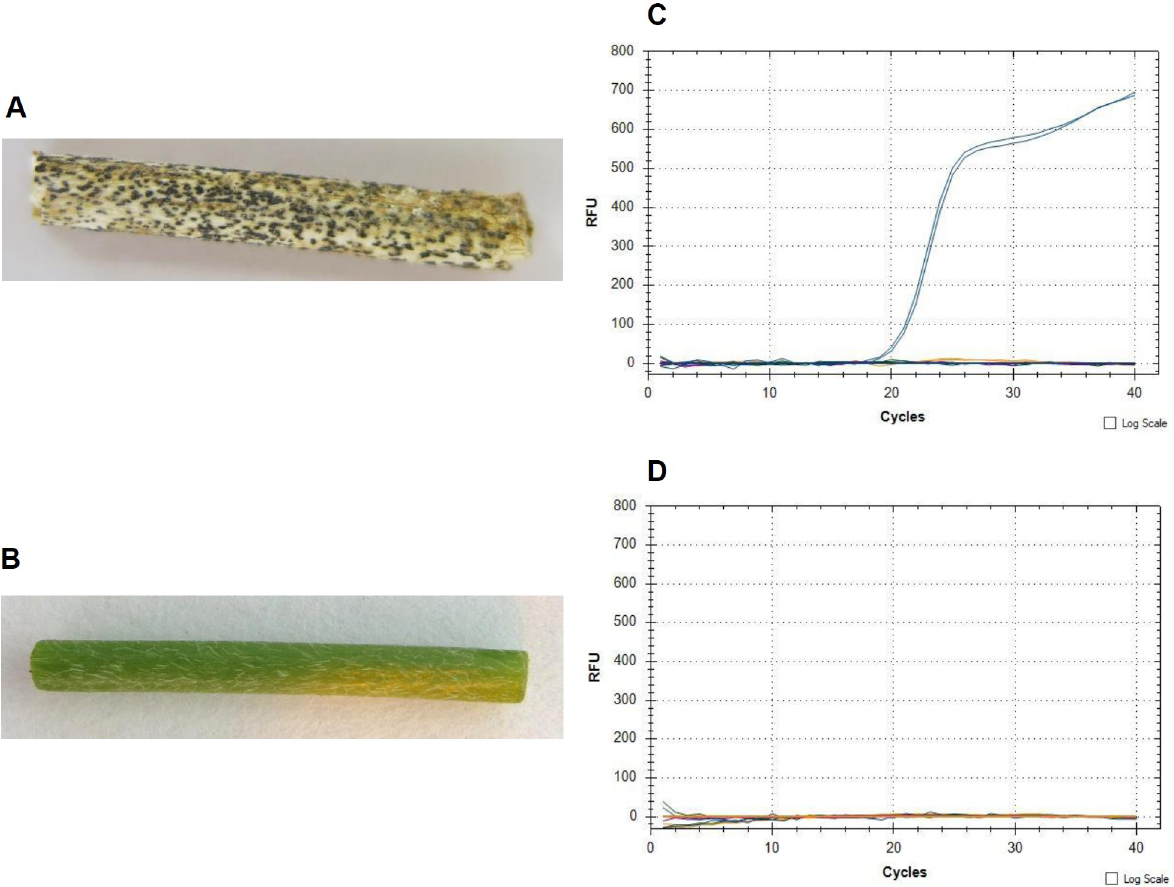
Fig 5. Validation of the quadruplex real-time PCR assay. (A) Soybean stem sample inoculated with D . longicolla isolate DPC-HOH26, (B) healthy soybean stem sample, (C) and (D) quadruplex real-time PCR on the stem samples shown in (A) and (B), respectively.